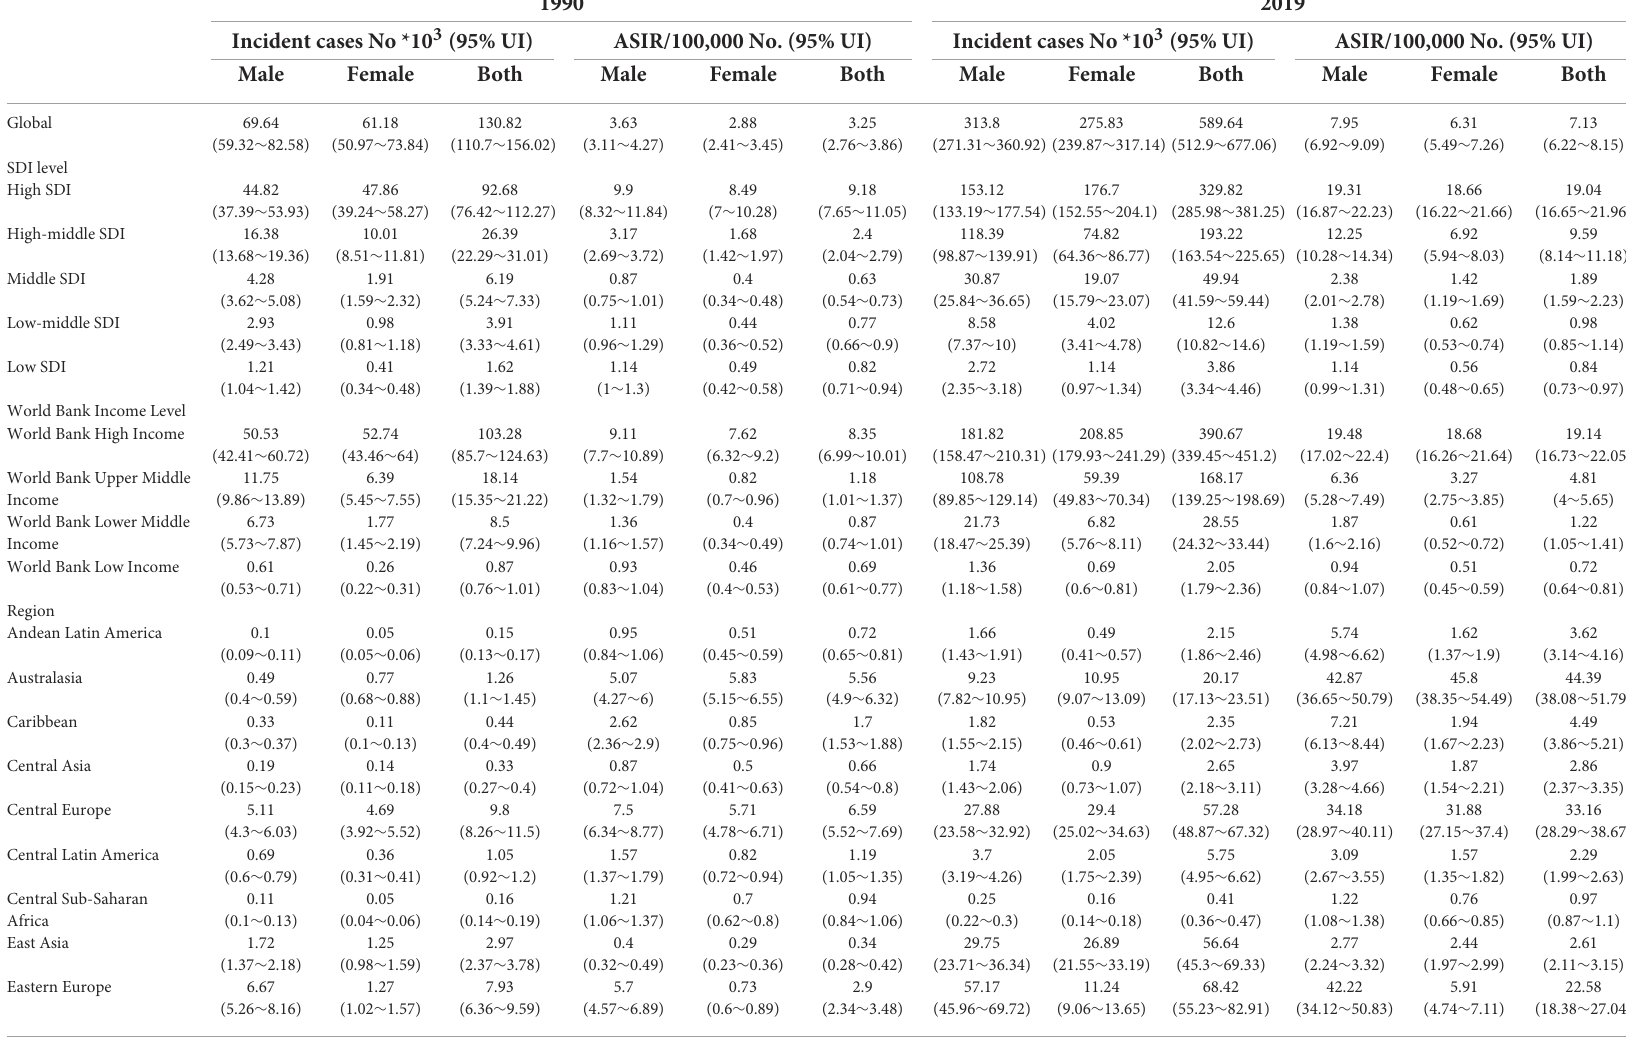
TABLE 1 The incidence of CAVD in